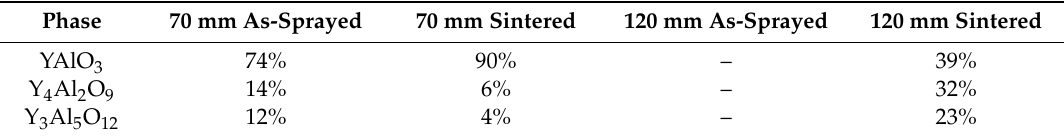
Table 2. Results of Rietveld refinements of APS YAlO 3 coatings.